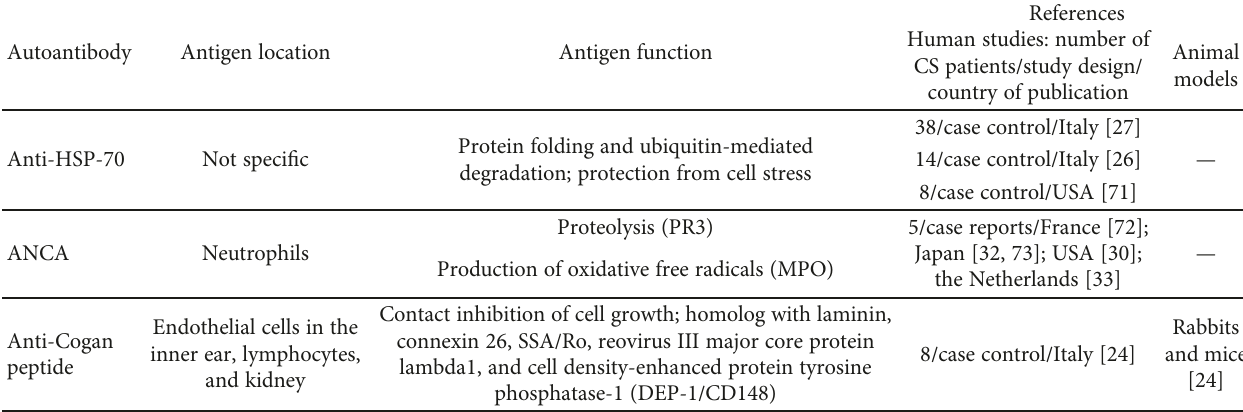
Table 1: Autoantibodies associated with Cogan ’ s